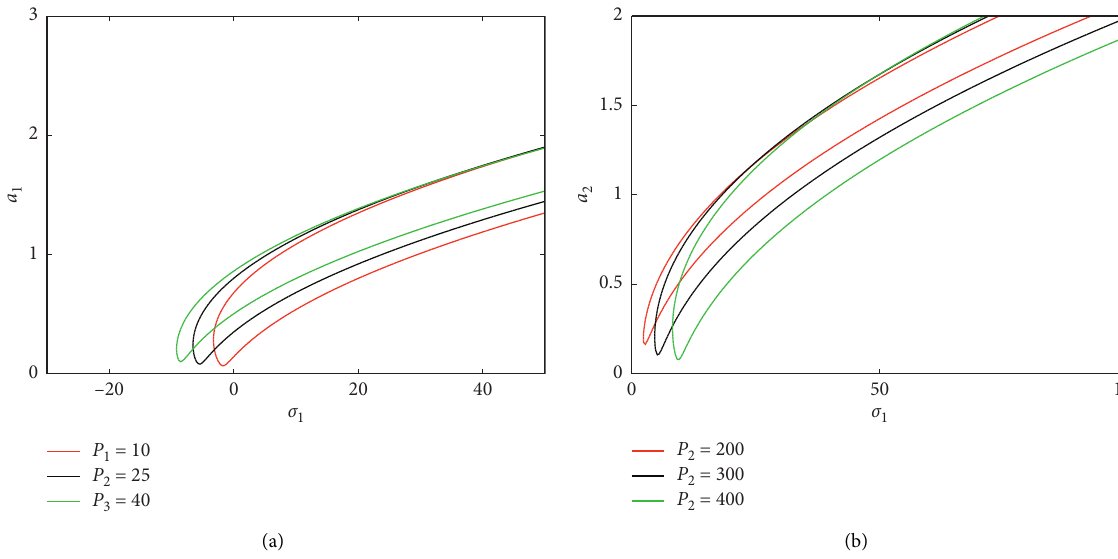
Figure 2: Amplitude-frequency response curves of the first-order and second-order mode for different excitation amplitudes.